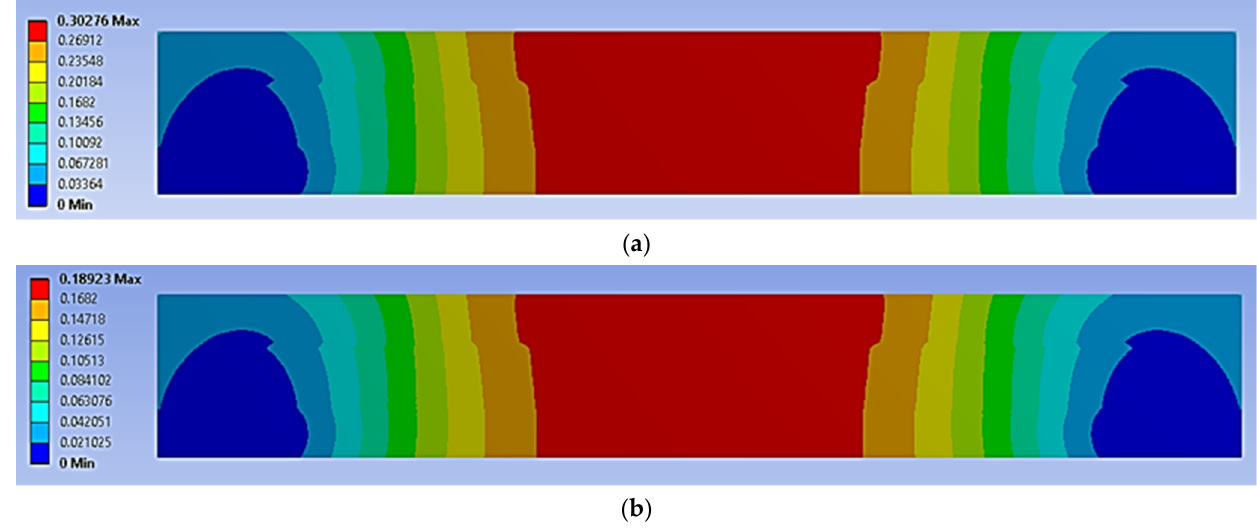
Figure 11. The permanent deformation experienced by a simulated panel under cyclic loading conditions (units in mm): ( a ) 70%, ( b ) 50%.